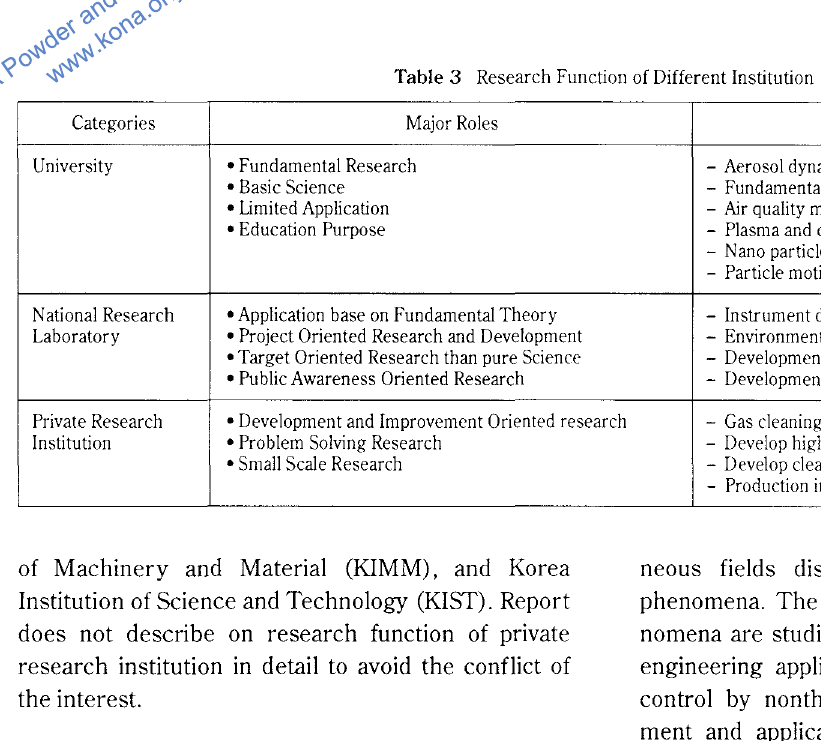
Table 3 Research Function of Different